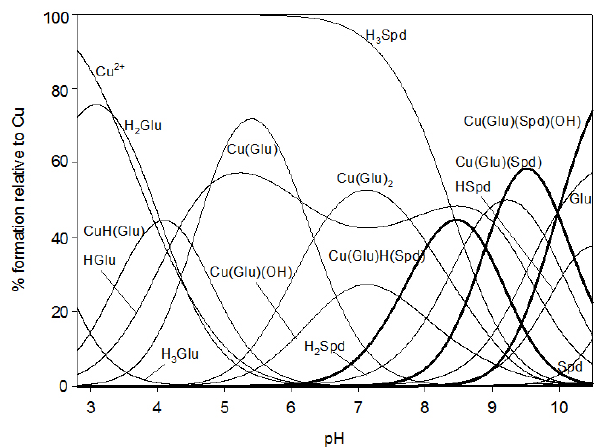
Figure 4: Distribution diagram for the Cu(II)/Glu/Spd; percentage of the species refers to total metal; C C = 3.03×10 -2 M; C = 3.03×10 -2 M. Glu Spd